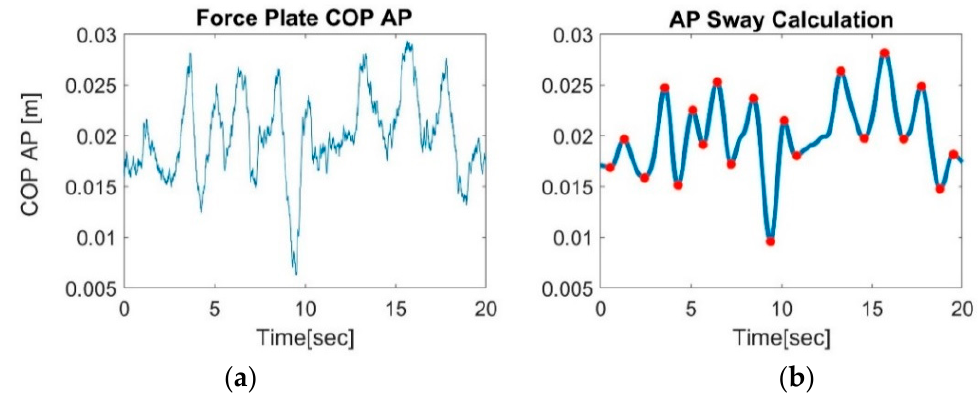
Figure 3. Sway calculations from the center of pressure (COP), measured using a force plate (FP). ( a ) Original FP’s COP output signal in the AP axis, recorded while standing on one leg. ( b ) Peak detection (red dots) over a smoothed COP signal from ( a ). For AP sway calculation, the average of all intervals between consecutive red peaks (peak-to-peak) was calculated.